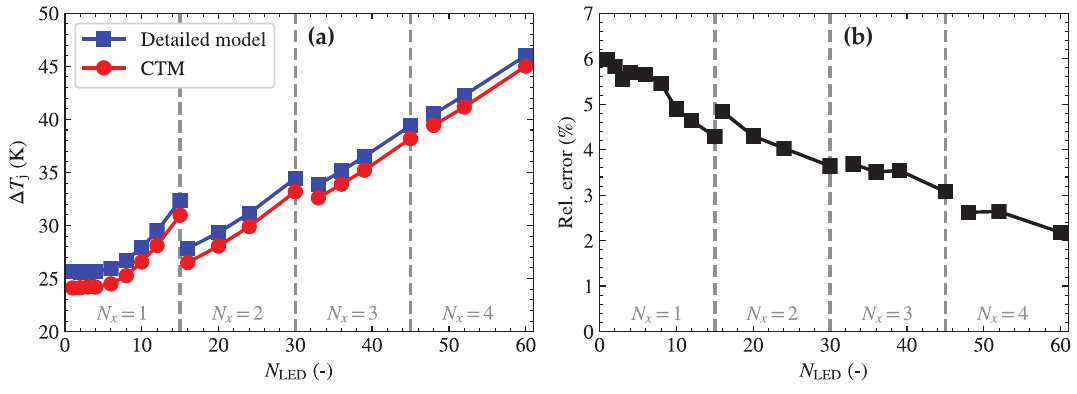
Figure 9. Average junction temperature rise of the LEDs in the LED module-level model: ( a ) comparison between the LED detailed model and the LED CTM, and ( b ) the relative error in the LED CTM values for different number of